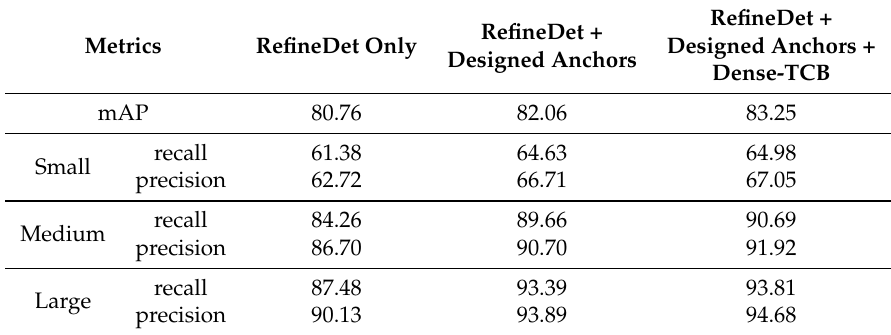
Table 3. Improvements brought by the designed anchors or the proposed Dense-TCB on the Tsinghua-Tencent 1009K test